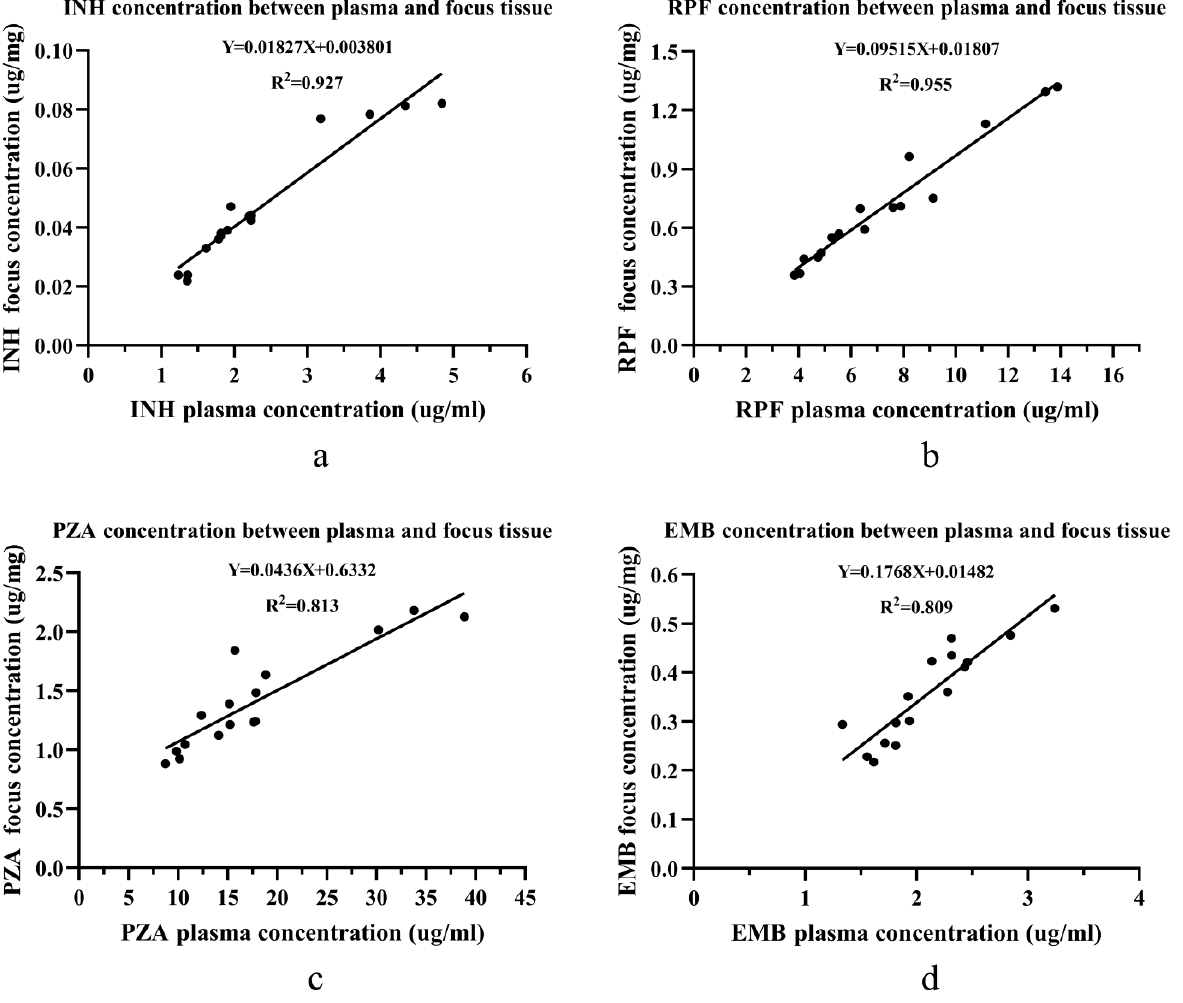
Figure 3. The linear relationship of four drug concentrations between the plasma and the focus tissue in the non-sclerotic bone group: ( a ) the linear relationship for INH; ( b ) the linear relationship for RPF; ( c ) the linear relationship for PZA; and ( d ) the linear relationship for EMB. Abbreviations: isoniazid (INH), rifampin (RPF), pyrazinamide (PZA), and ethambutol (EMB). Linear regression was used to find the concentration relationship between the plasma and the focus tissue.